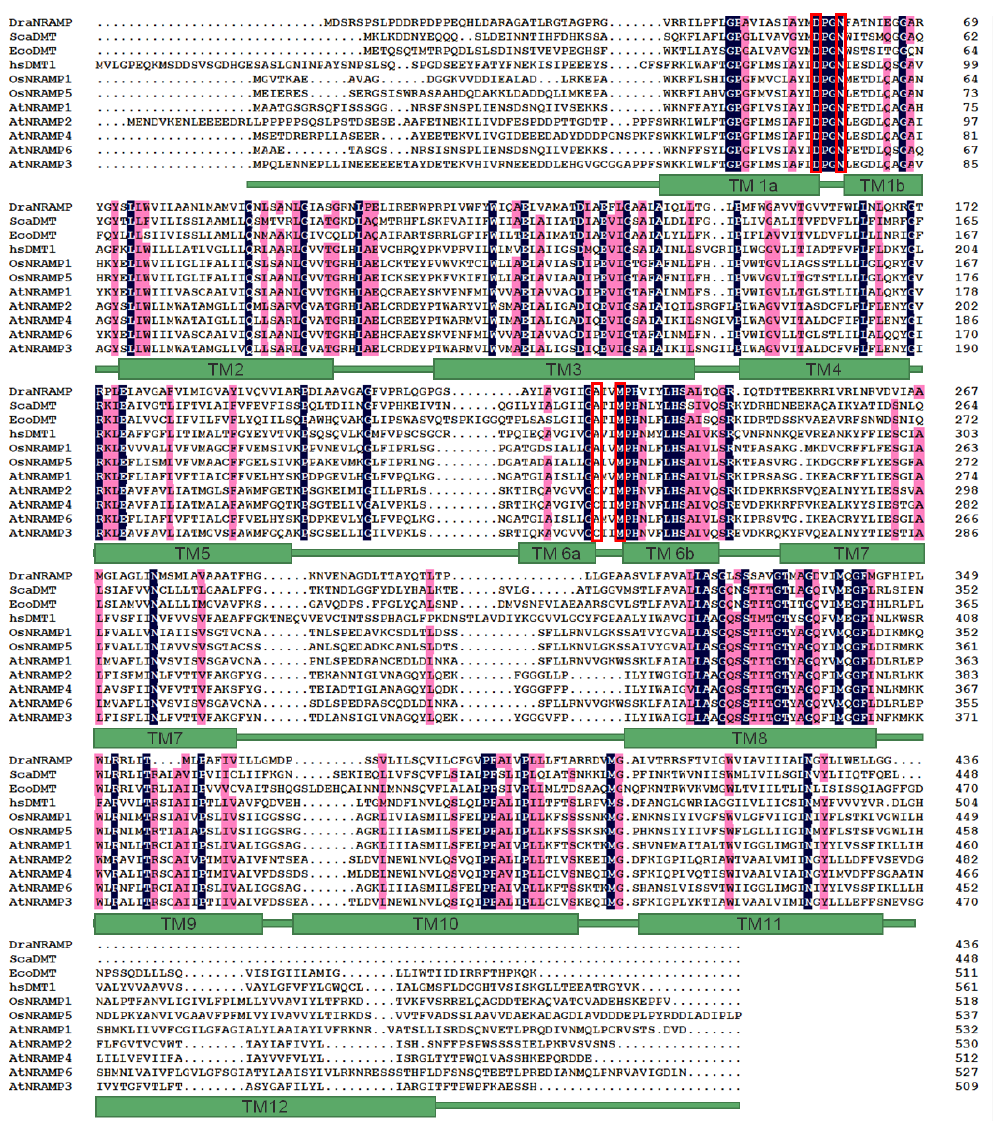
Figure 2. Amino acid sequence alignment of AtNRAMP3 with other NRAMP proteins. AtNRAMP1 (GenBank Acc. No. At1g80830), AtNRAMP2 (GenBank Acc. No. AT1G47240), AtNRAMP3 (GenBank Acc. No. AT2G23150), AtNRAMP4 (GenBank Acc. No. AT5G67330), and AtNRAMP6 (GenBank Acc. No. At1g15960) from Arabidopsis thaliana , OsNRAMP1 (Phytozome: LOC_ Os07g15460) and OsNRAMP5 (Phytozome: LOC_ Os07g15370) from Oryza sativa , Staphylococcus capitis ScaDMT (UniProtKB identifier A0A178L6Y2-1), Deinococcus radiodurans DraNRAMP (UniProtKB identifier Q9RTP8 ), Eremococcus coleocola EcoDMT (UniProtKB identifier E4KPW4) and human DMT1 (UniProtKB identifier P49281-2) were aligned. Identical residues are highlighted in mazarine, similar residues in pink. The putative transmembrane regions of the AtNRAMP3 were predicted based on the alignment with EcoDMT and the sequences are shown below. Selected residues of ion-binding site are indicated within a red frame.